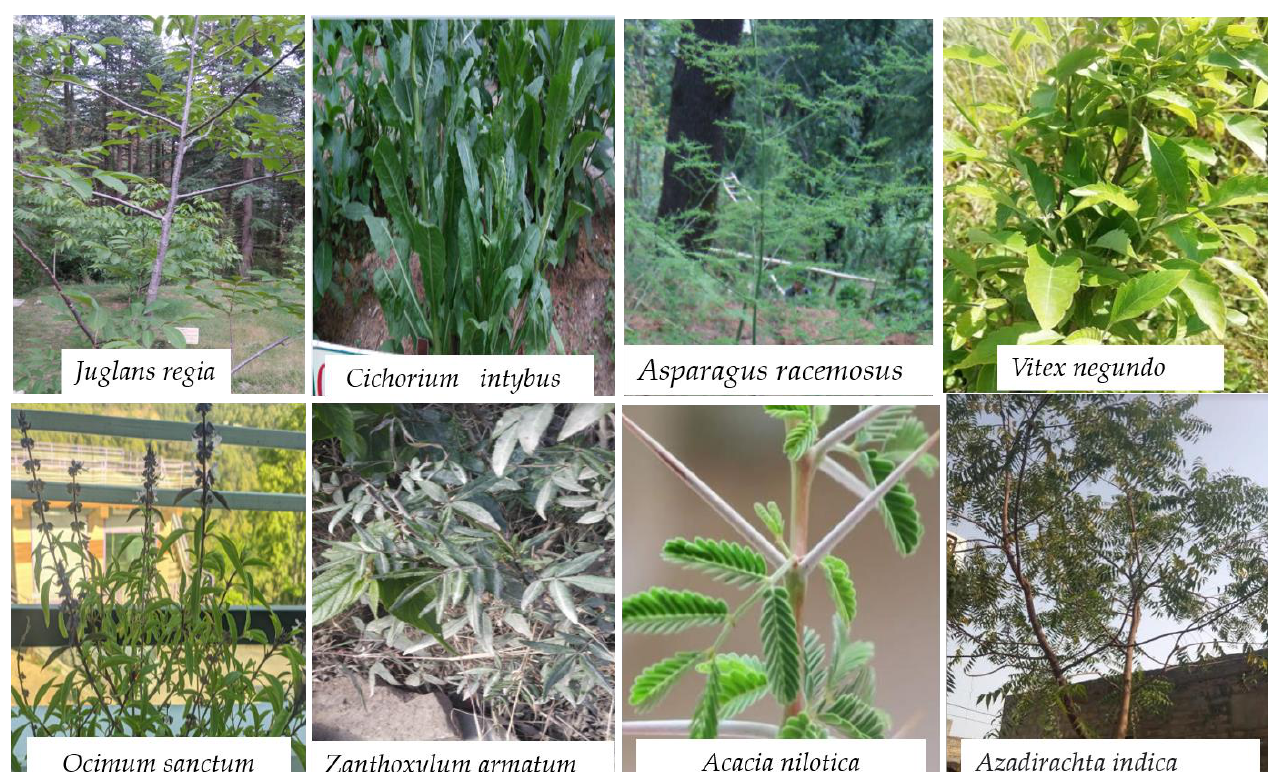
Figure 1. Photographs showing important medicinal plants with a beneficial role in oral health.